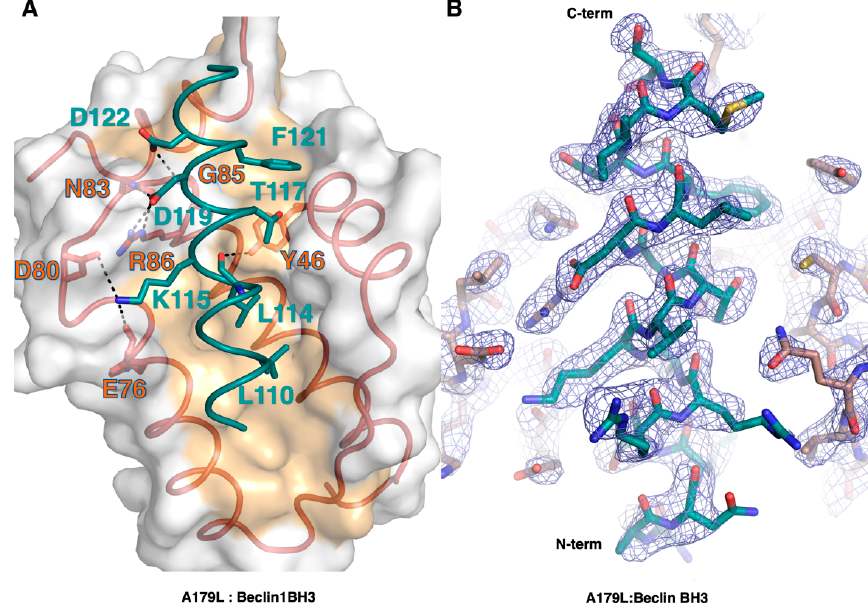
Figure 4. Detailed view of the A179L:BH3 peptide interfaces. ( A ) A179L is shown as a grey molecular surface, with the backbone and floor of the binding groove shown in green and orange, respectively. Beclin BH3 is shown in cyan. The four conserved hydrophobic residues of Beclin BH3 (L110, L114, T117, F121) engage the binding groove and the family-defining salt bridges formed by A179L R86 and Beclin D119 are labeled. Additional ionic interactions and hydrogen bonds are shown as black dots. ( B ) 2Fo-Fc electron density map (blue mesh) of Beclin BH3 peptide (cyan) bound to A179L (orange). Map is contoured at σ 1.5.